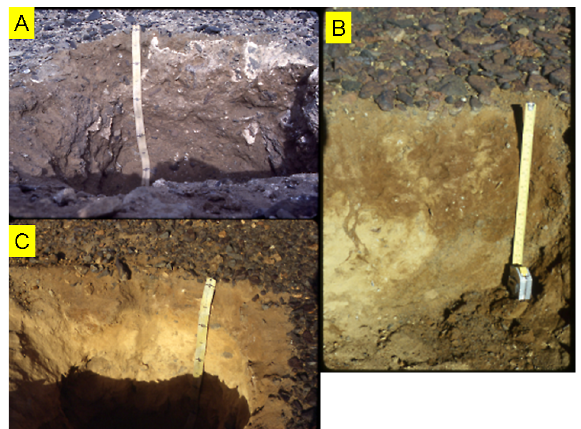
Fig. 4. Relict soils and features in the Transantarctic Mountains: (A) one of the most strongly developed soils we have observed in the Transantarctic Mountains, this soil is derived from Alpine IV drift in central Wright Valley, contains stage 6 salts, and is likely of Pliocene age (pedon 84–47); (B) cryoturbation in a soil now con- taining dry permafrost in the Labyrinth, upper Wright Valley (pedon 79–08); (C) a fossil sand wedge that passed through a soil derived from Taylor IV drift (Pliocene) and into a soil derived from Altar drift (Miocene) in upper Arena Valley (pedon